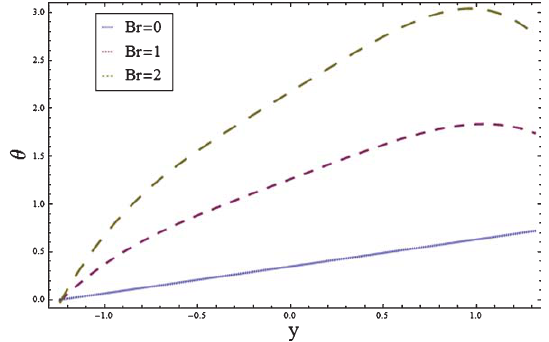
Fig. 6. Plot showing θ versus y . Here a = 0 . 3, b = 0 . 5, d = 1, φ = π/ 4, (cid:14) = 1 . 5, n = 0 . 398, Bi 0 . 1.